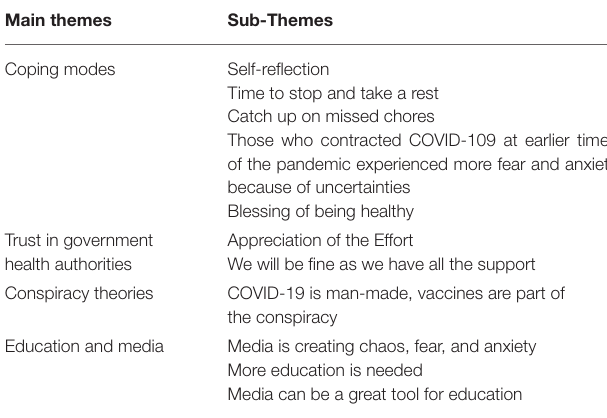
TABLE 3 | Emerging